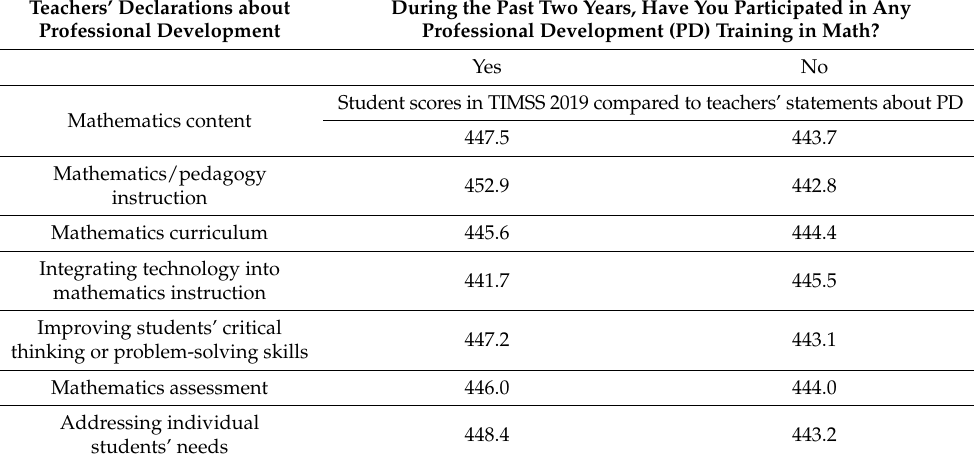
Table 5. The professional development of teachers compared with the average scores of students in mathematics.